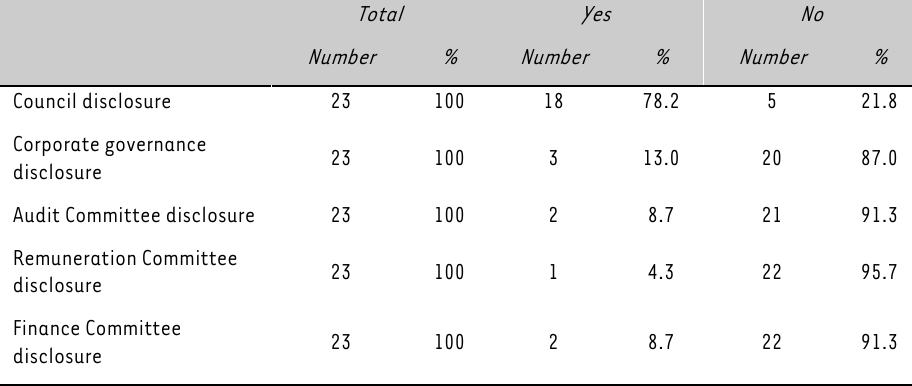
TABLE 1: Corporate governance disclosures